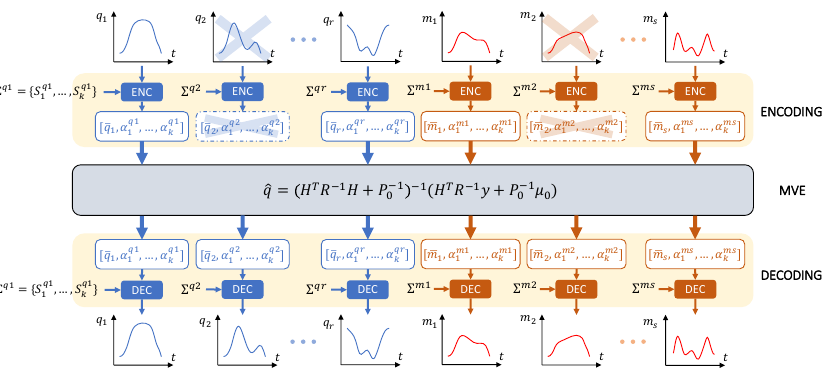
Figure 1. Schematic flow of the estimation procedure. First temporal signals are mapped on the weight vector through the fPC bases ( Encoding ). After that, Minimum Variance Estimation (MVE) fuses the encoded measures with a priori knowledge to estimate for the missing part of measures. In the end, the estimated weight vector is converted back to the temporal domain ( Decoding